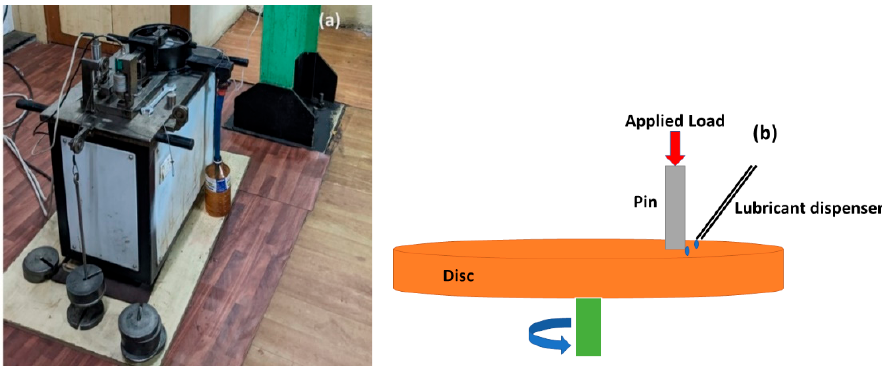
Figure 4. ( a ) Pin-on-disc equipment with lubrication facility, and ( b ) schematic diagram of the pin on the disc.